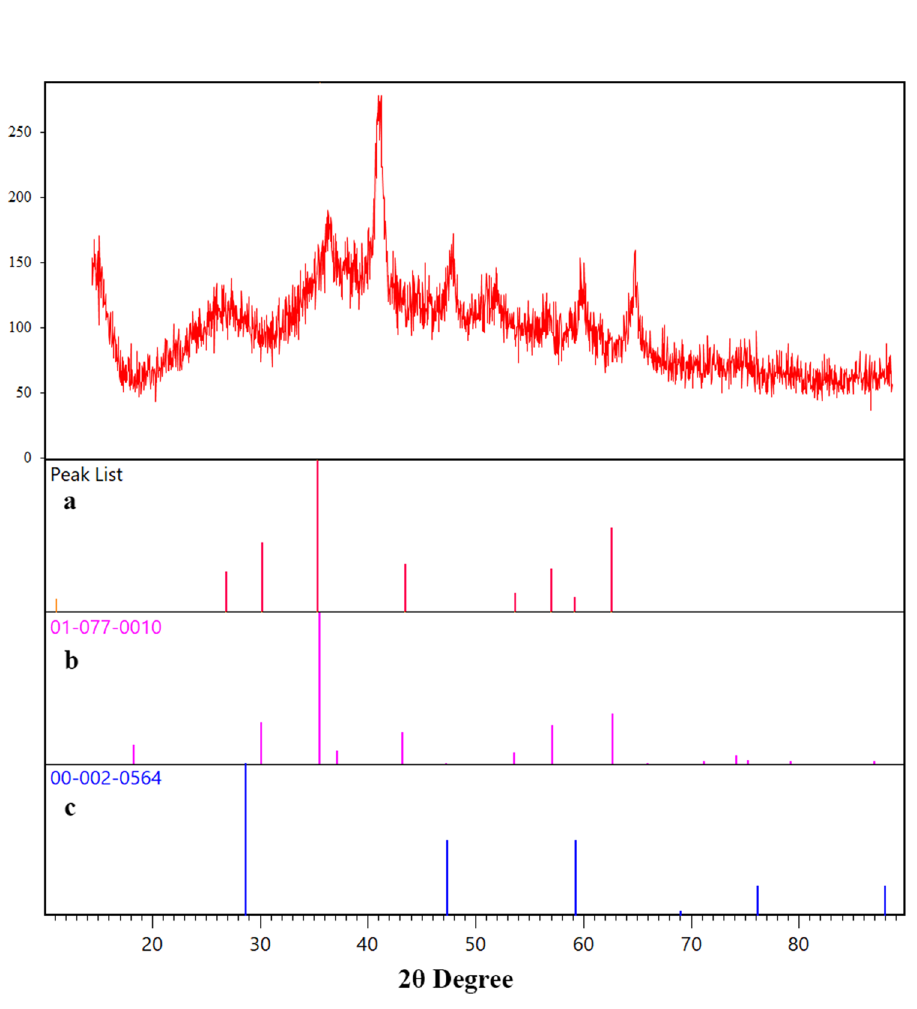
Figure 6. The XRD pattern of ( a ) the agar supported ZnS/CuFe 2 O 4 ( b ) standard CuFe 2 O 4 and ( c ) standard